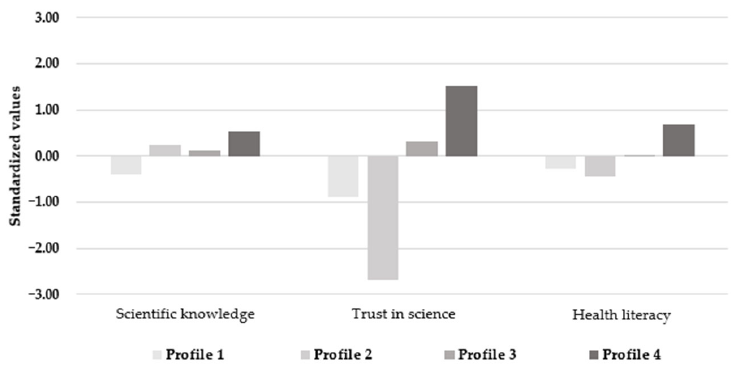
Figure 1. Z -standardized values of the indicator